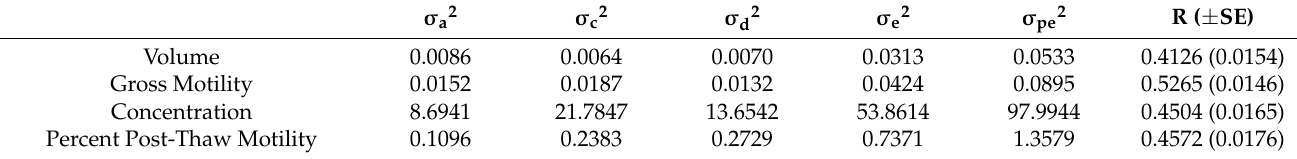
Table 2. Genetic parameter estimates for the four transformed ejaculate traits studied, volume, gross motility, concentration, and percent post-thaw motility. σ a2 σ c2 σ d2